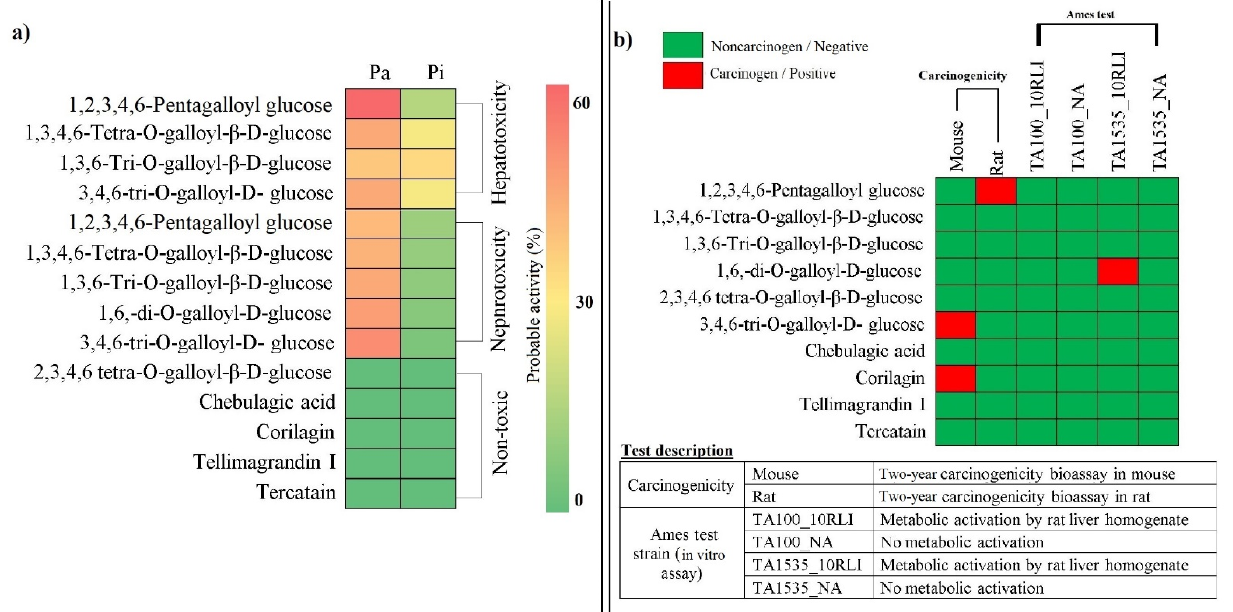
Figure 12. Heat map representation of phytocompounds with their probable ( a ) side effects and ( b ) toxicity.